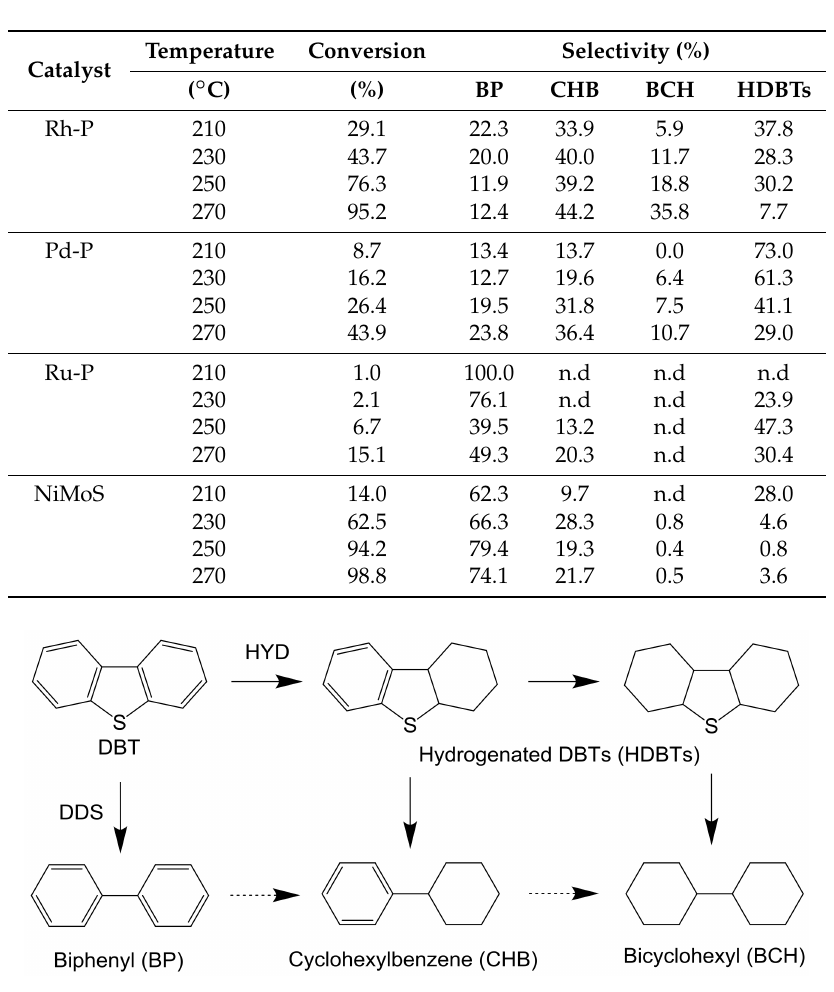
Scheme 1. Reaction pathway for the HDS of